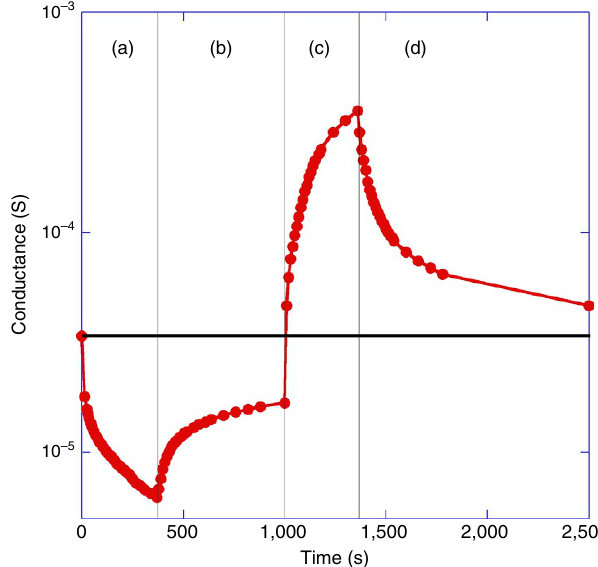
Figure 5 | Applying a voltage across the film/substrate interface. Measurements of the average conductance between electrodes 1 and 7, plotted versus time when a voltage is applied between electrodes 4 and 4b using a battery (see Fig. 1 for the electrode configuration).